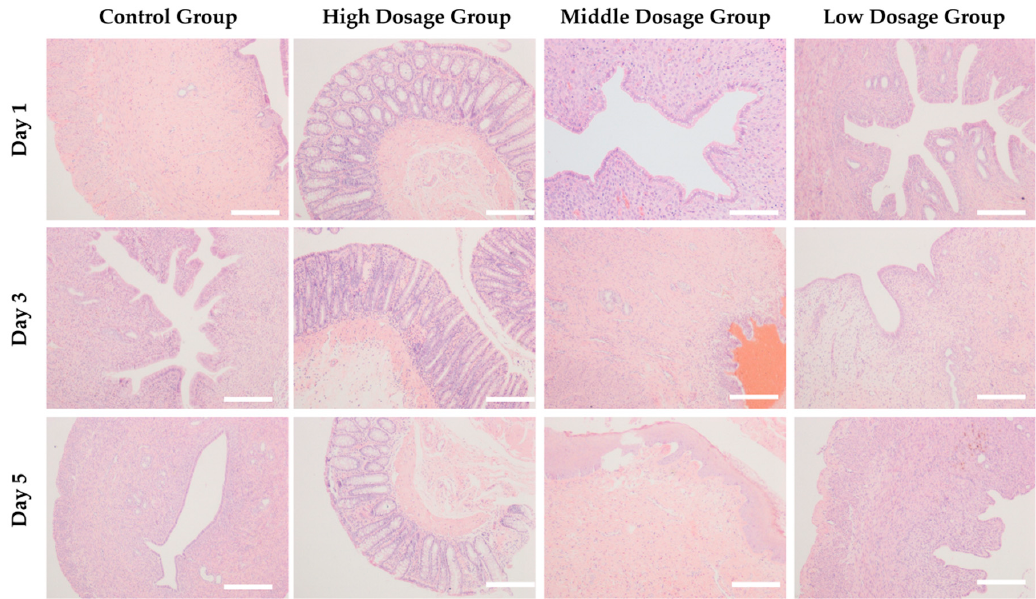
Figure 6. Hematoxylin ‐ eosin (HE) staining of Sprague ‐ Dawley (SD) rat uterus at various indicated days after injecting hydrogels with different drug dosages into the vagina (high dosage, middle dosage, and low dosage). The CP ‐ 3 block copolymer solution at the concentration of 30 wt% was used. The volume of drug ‐ loaded copolymer solution injected into the vagina is 0.2 mL. Copolymer solutions without loading drug were injected into the vagina of SD rats as a control group, scale bar: 20 µ m.